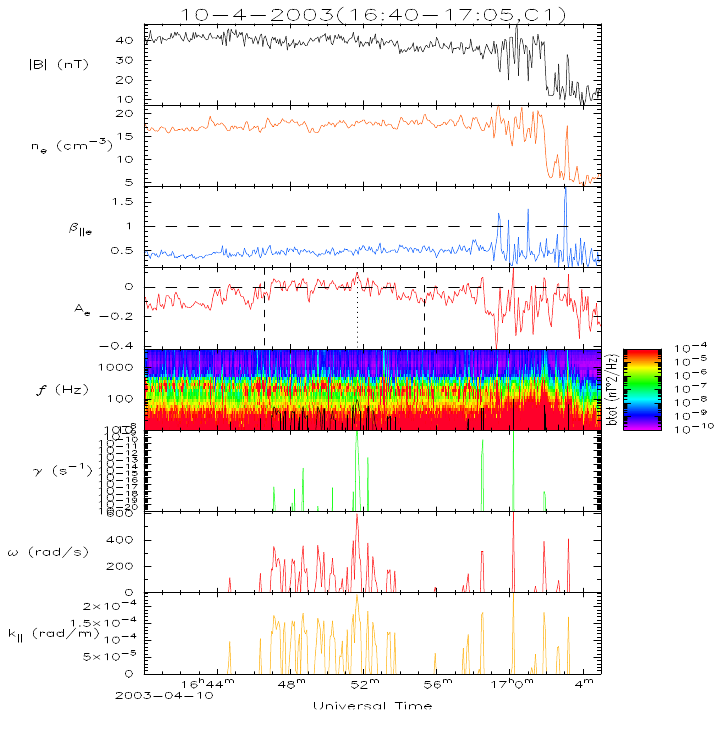
Fig. 3. From 16:40 to 17:05 UT on 10-4-2003 on C1. Format as in Figure 1.